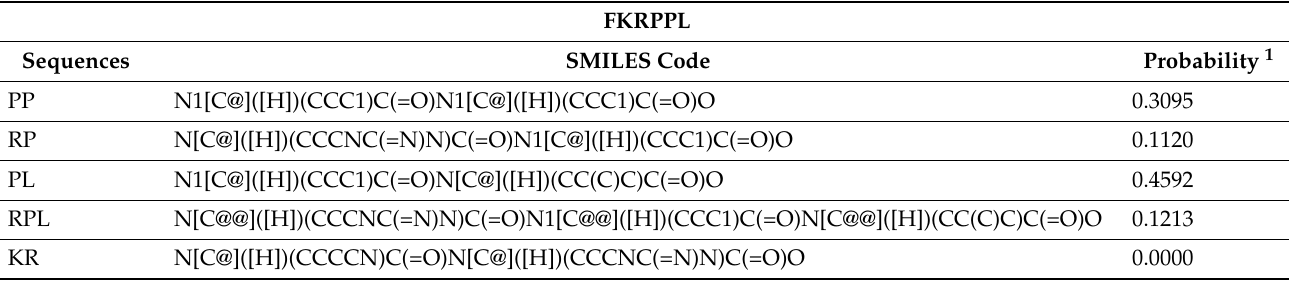
Table 4. The result of predicting the likelihood of bioactive small peptides acting as DPP-IV